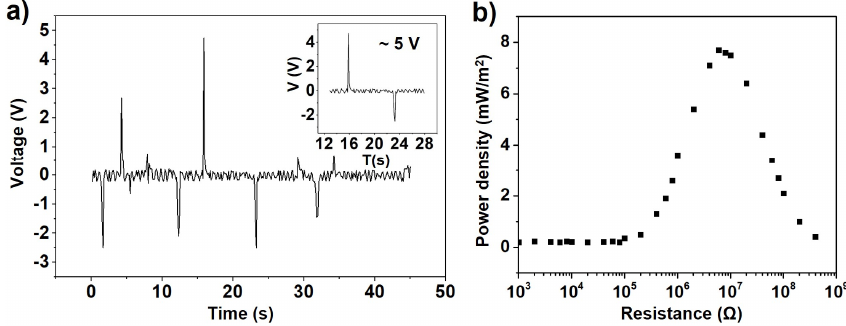
Figure 6. ( a ) The output voltage of the as-formed durable TENG device. ( b ) The relationship between power density and load resistance for the as-formed durable